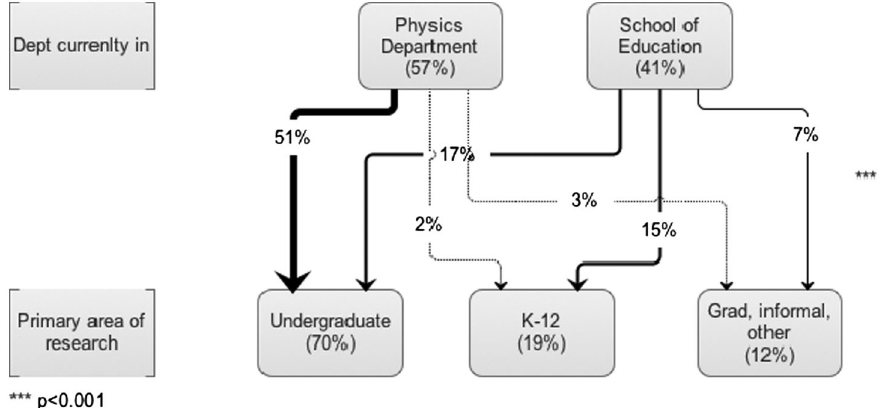
FIG. 3. PER graduate students ’ primary areas of research (values are the percentage of the total